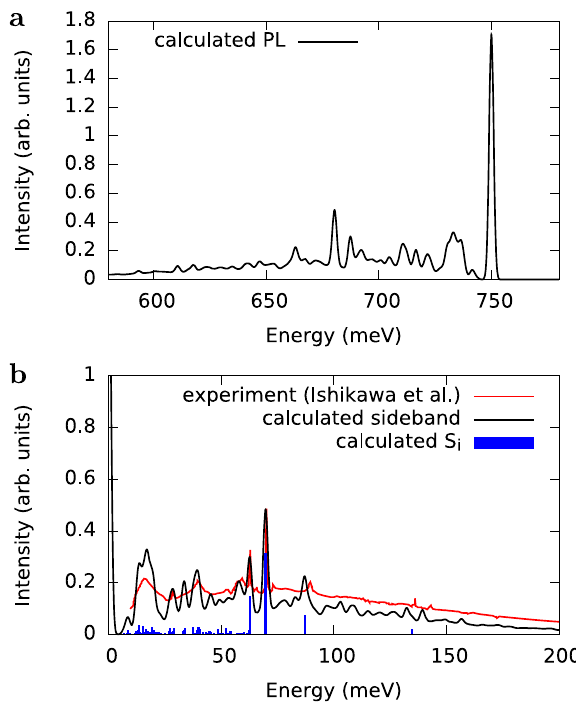
Fig. 2 Simulated photoluminescence spectrum. a Calculated PL spectrum of C i O i0 defect, showing Huang-Rhys factor of S = 2.1. b Calculated PL sideband relative to the ZPL energy and the S partial Huang – Rhys factors. Our results are compared to the experimental PL sideband reported by Ishikawa et al. 31